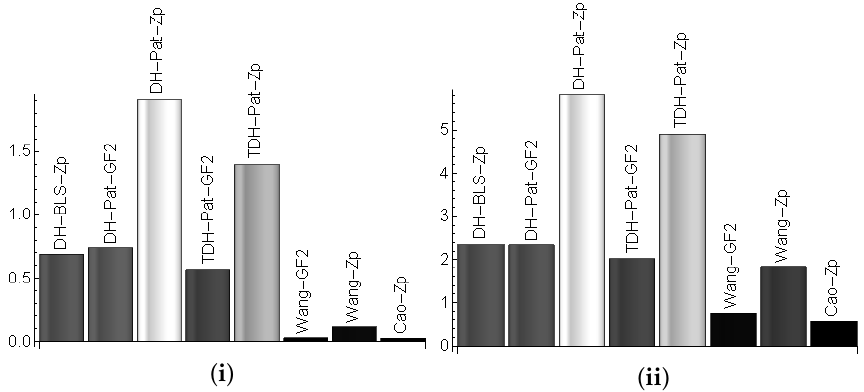
Figure 6. Computational time (s) on one node ( i ) and estimated computational time for 4 nodes ( ii ) (based on Infineon TC297 results).